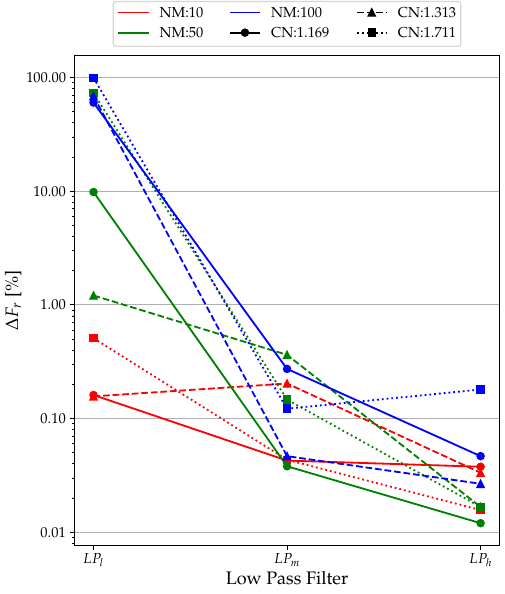
Figure 10. Low-pass filter analysis: ∆ F results.